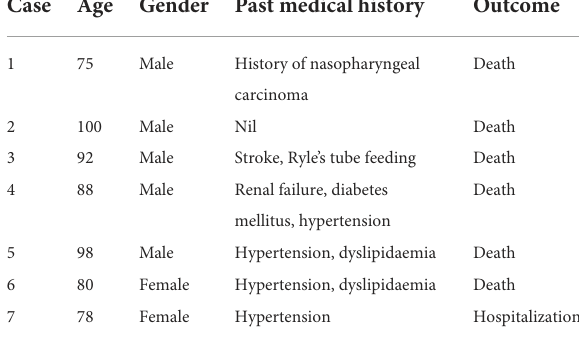
TABLE 3 SARS-CoV-2 RT-PCR results of 66 elderly COVID-19 patients after administration of JHQG in the convalescent